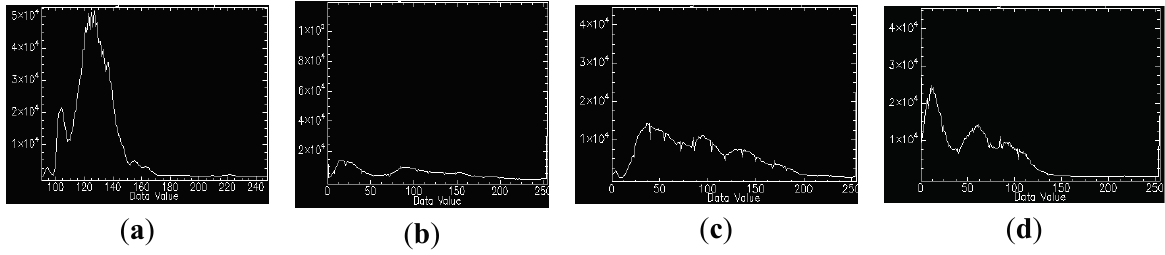
Figure 11. Histograms of the four band images; ( a – d ) respectively the histograms of the infrared band, red band, green band and blue band.